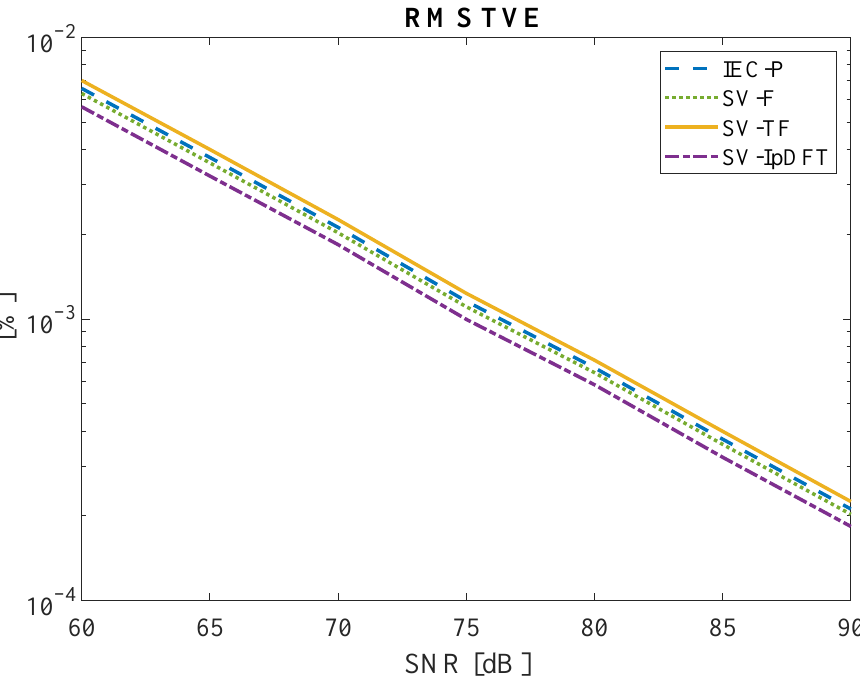
Figure 13. RMS TVE in the presence of additive wideband noise at different